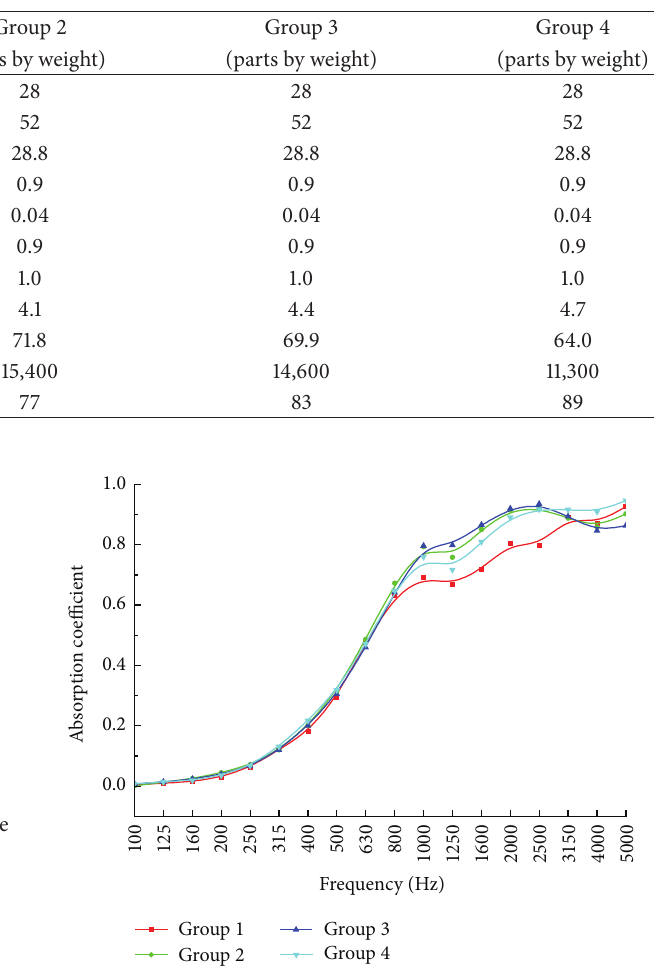
Table 3: Main components and properties of the foam.